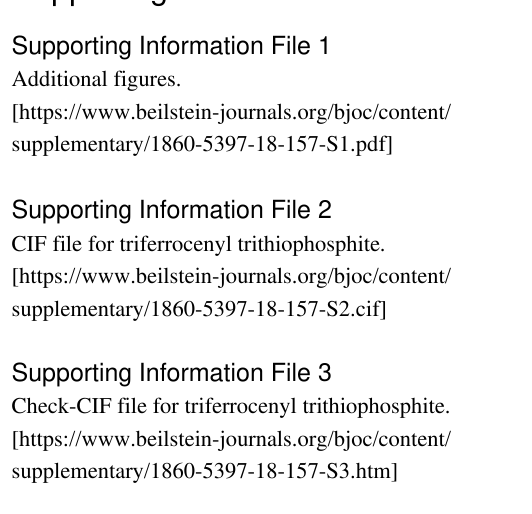
forming the C–H··· π -bonded dimers (Figures S4 and S5 in Sup- porting Information File 1). The computations of the relative energies of five possible conformers of (PhS) 3 P ( ggg , ttt , ttg , ggt , ccg ) predict the lowest energy for the ccg conformation (Figure 5). The propeller-like ggg conformer found in the